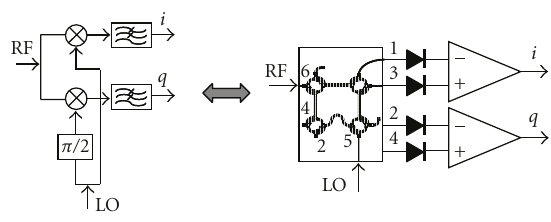
Figure 2: Equivalence between the conventional I/Q mixer and the multiport mixer.